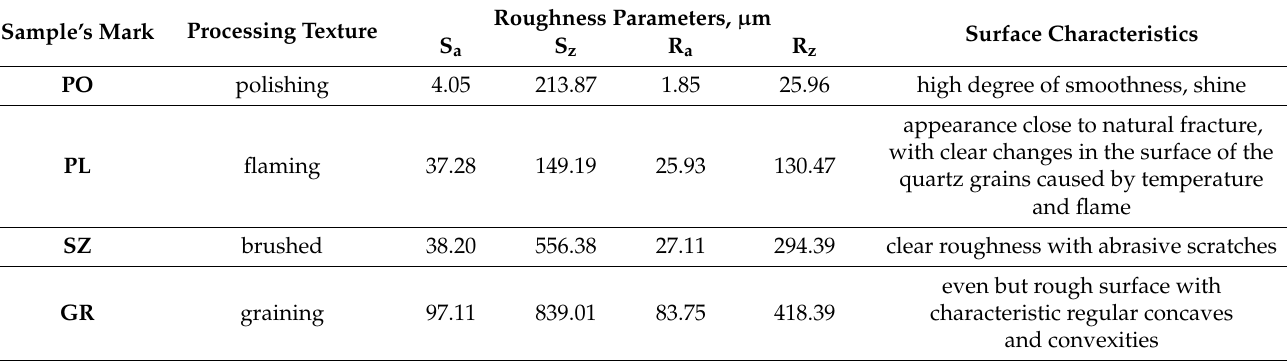
Table 1. Characteristics of granite